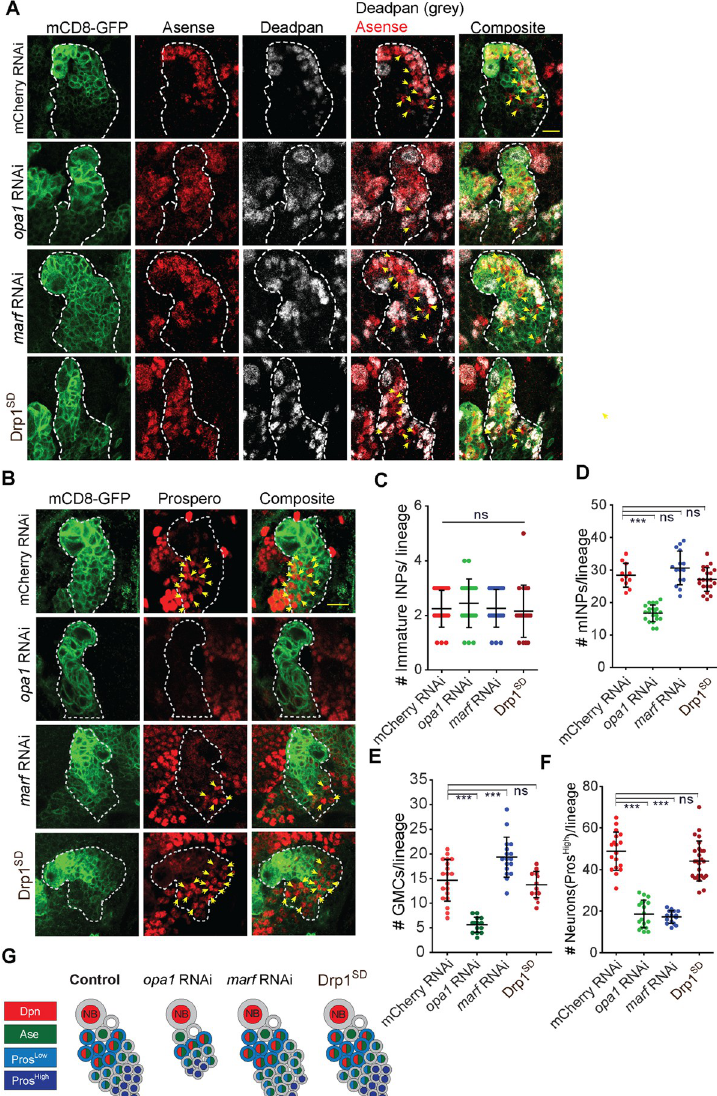
Fig 2. Analysis of change in mature INPs, GMCs and neurons in the type II NB lineage on depletion of mitochondrial morphology proteins. A-F: Representative images of the type II NB lineage showing that Dpn positive mature INPs (grey) and Dpn negative, Ase positive GMCs (yellow arrows) are reduced in opa1 RNAi (A). Quantification of Dpn positive mature INPs per type II NB lineage (D) in mCherry RNAi (n = 11 type II NB lineages, 4 brains), opa1 RNAi (21,6), marf RNAi (15,8), Drp1 SD (28,10). Quantification of GMCs per type II NB lineage (E) in mCherry RNAi (n = 19 type II NB lineages, 6 brains), opa1 RNAi (14,5), marf RNAi (17,6), Drp1 SD (14,5) Scale bar- 10 μ m. Quantification of Ase negative and Pros negative (Ase- Pros-) (C) immature INPs per type II lineage. mCherry RNAi (24 type II NB lineages,5 brains), opa1 RNAi (20,7), marf RNAi (23,8), Drp1 SD (19,8). Representative images of type II NB lineages showing high levels of Pros expressing young neurons are reduced in opa1 RNAi and marf RNAi (B). Quantification of number of young neurons expressing high levels of Pros (yellow arrows point to nuclear Pros) per type II NB lineage (F) of mCherry RNAi (13 type II NB lineages,4 brains), opa1 RNAi (18,5), marf RNAi (19,5), Drp1 SD (26,9). Scale bar- 10 μ m. G: Schematic depicting the effect of depletions of Opa1, Marf and Drp1 on different cell types in the type II NB lineage. C-F: Graphs show mean ± sd. Statistical analysis is done using an unpaired t-test. ns = non-significant, ��� - p < 0.001.